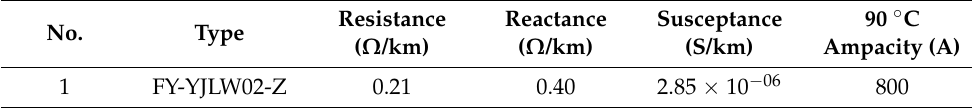
Table 17. Specifications of buried cables with 110 kV.